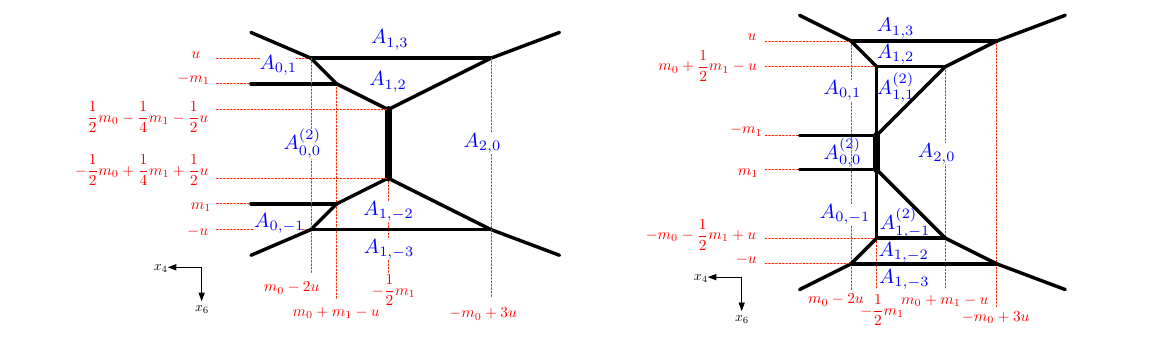
in Figure 30. The regions for the largest A ( m ) k;l Region 10 of the E 2 theory.